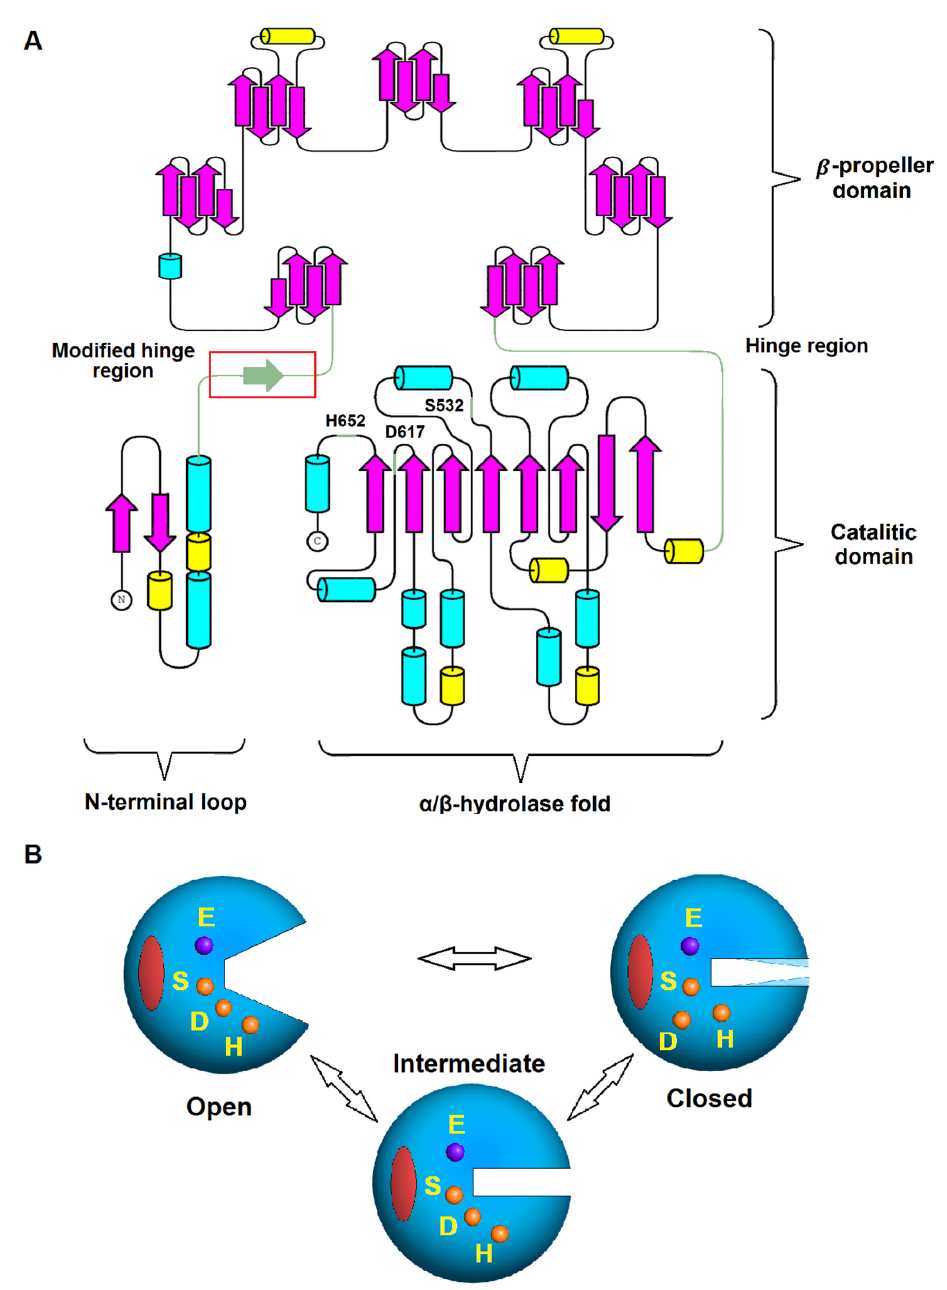
Figure 1. The structure and conformational states of POPs. ( A ) The schematic representation of a typical structure of POP demonstrates a domain swap in the catalytic domain. The topology was prepared using the SpOPB crystal structure. Secondary structure elements are shown in black (loops), cyan ( α‐ helices), yellow (3 10 helices), and magenta ( β‐ strands). The residues of the catalytic triad are numbered according to the SpOPB sequence. Pale green shows the hinge peptides. The residues of the first hinge peptide IPQQEH, which were changed to ENLYFQ in SpOPBmod, are marked with a red square. ( B ) The schematic representation of the three conformations observed in the POP crystal structures. The residues of the catalytic triad and S1 substrate binding center are shown by the orange and violet balls, respectively; the hinge is a red ellipse.